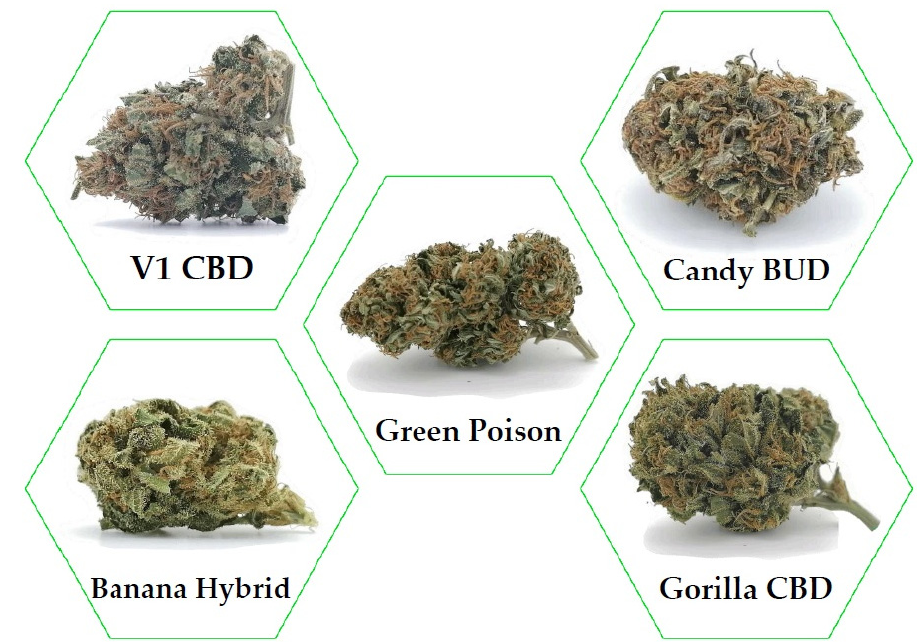
Figure 1. Inflorescences from five different Cannabis sativa L.